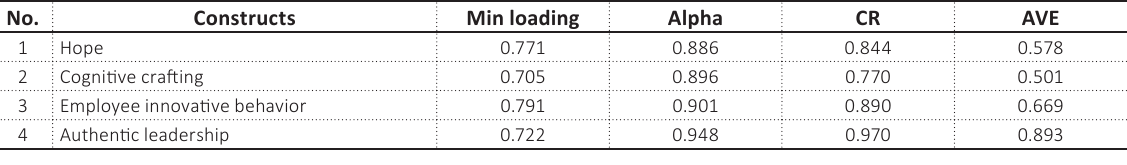
Table 2. Descriptive statistics and correlation matrix